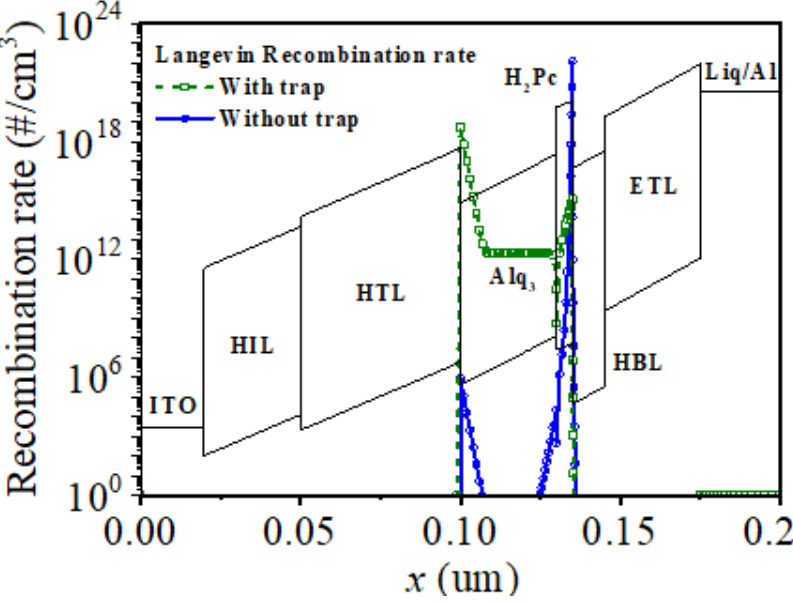
Figure 10. Schematic of electron transport in the case of ( a ) a large number of traps before thermal treatment and ( b ) a small number of traps after thermal treatment.